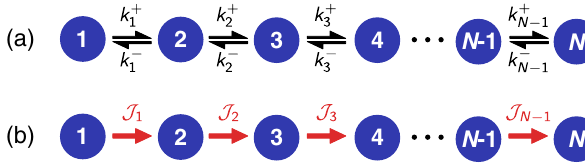
FIG. 9. (a) N -state Markov model on a one-dimensional lattice graph, with E ¼ N − 1 edges. Black arrows correspond to transitions between neighboring states, k þ i ð λ t Þ and k − i ð λ t Þ , i ¼ 1 ; … ; N − 1 , which depend on the control protocol λ (b) Oriented stationary currents J α ð t Þ , α ¼ 1 ; … ; N − 1 . These currents form the only spanning tree for the